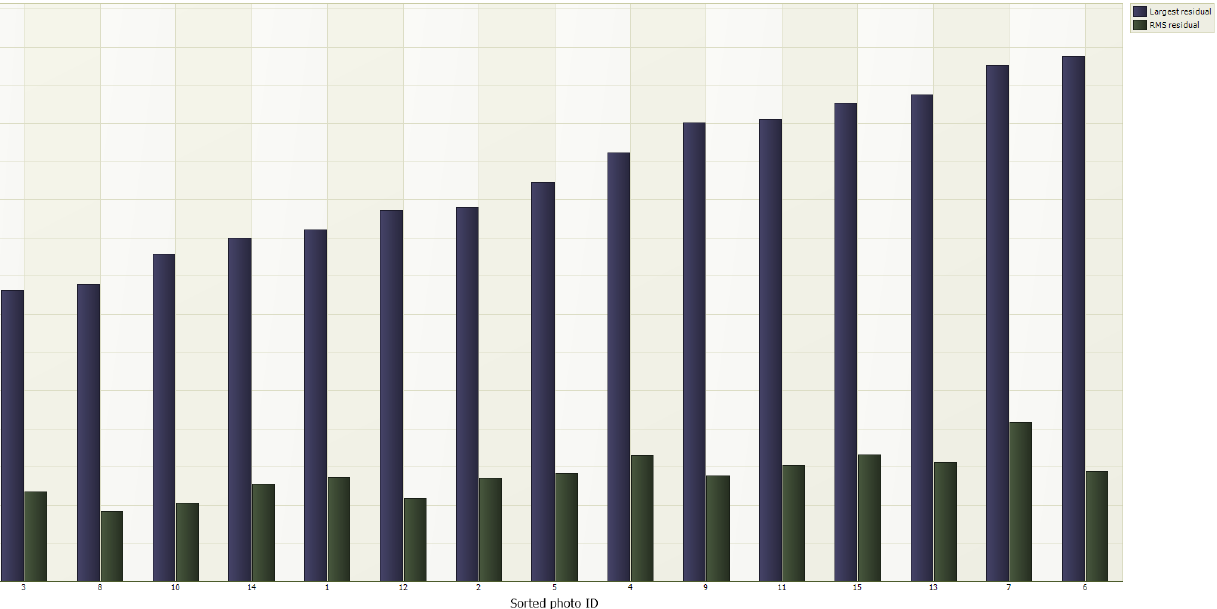
Figure 20. Calibration errors for different photos.